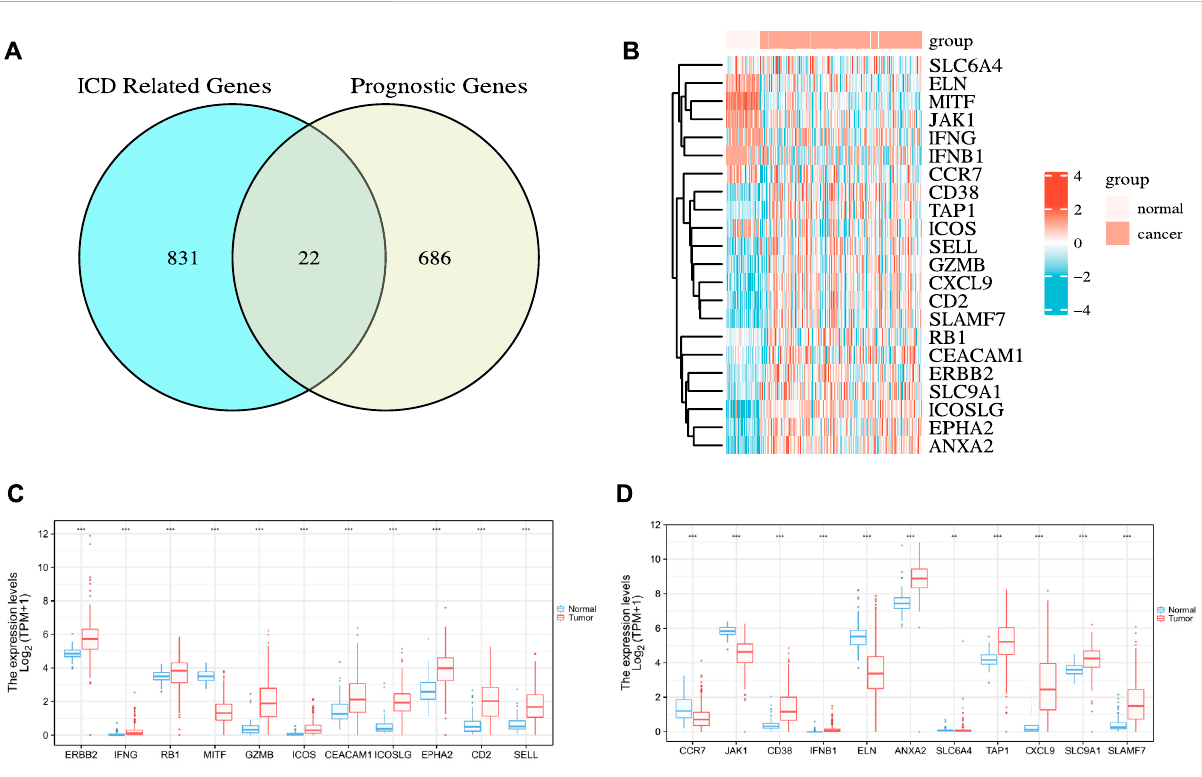
FIGURE 2 Identi fi cation of the candidate ICD-related prognostic genes in the TCGA cohort. (A) Venn chart showing the number of OC prognostic genes associated with ICD-related genes. (B) Heatmap of the expression of 22 overlapping genes. (C,D) Box plot of the expressionlevelsof 22 overlapping genes in OC and normal ovarian tissue. p values are p ≤ 0.5 (*), p ≤ 0.01 (**), p ≤ 0.001